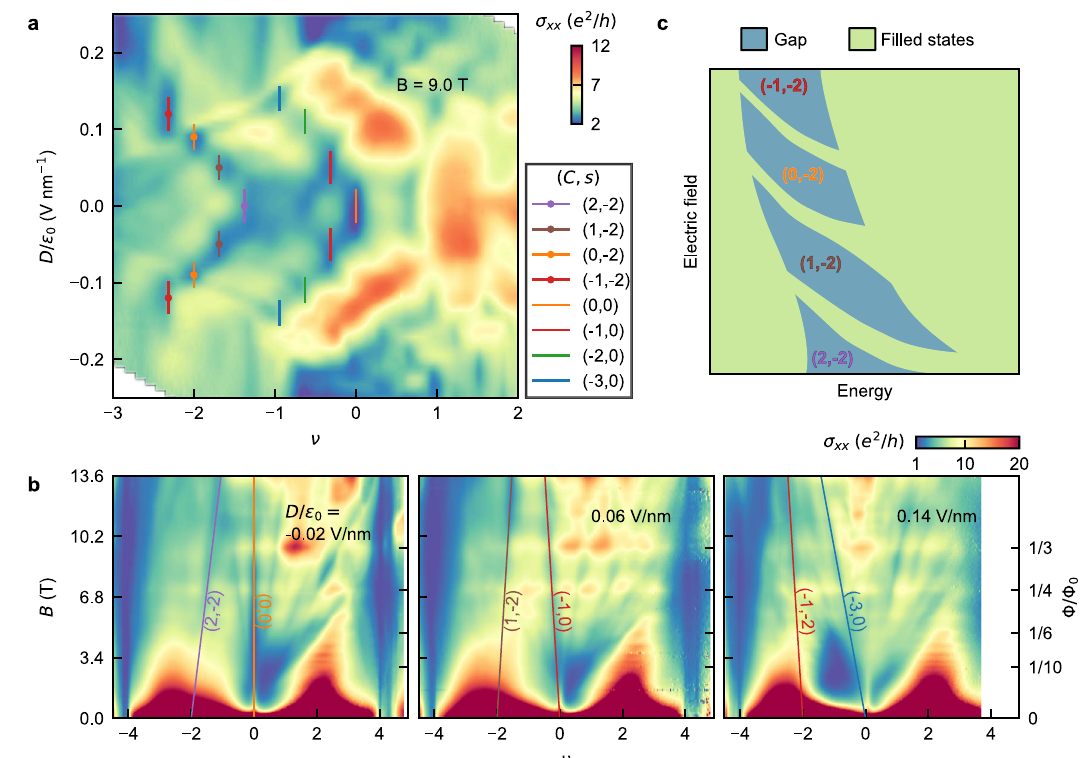
Fig. 2 | Electric fi eld tunable Chern gaps. a Color-scale plot of σ xx as a function ν and D at B =9T. The overlayed lines of different colors indicate the ( C , s ) values of the corresponding σ xx dips asinthe legend.( C , s ) valuesare inferred from b with C beingtheChernnumberand s beingthemoiré fi llingfactorcorrespondingto B =0 T(seeSupplementaryFig.6 for fi tting details to extract( C , s )values). b Color-scale plotsof σ xx asafunctionof ν and B ,i.e.,fandiagrams,atthreedifferentvaluesof D .